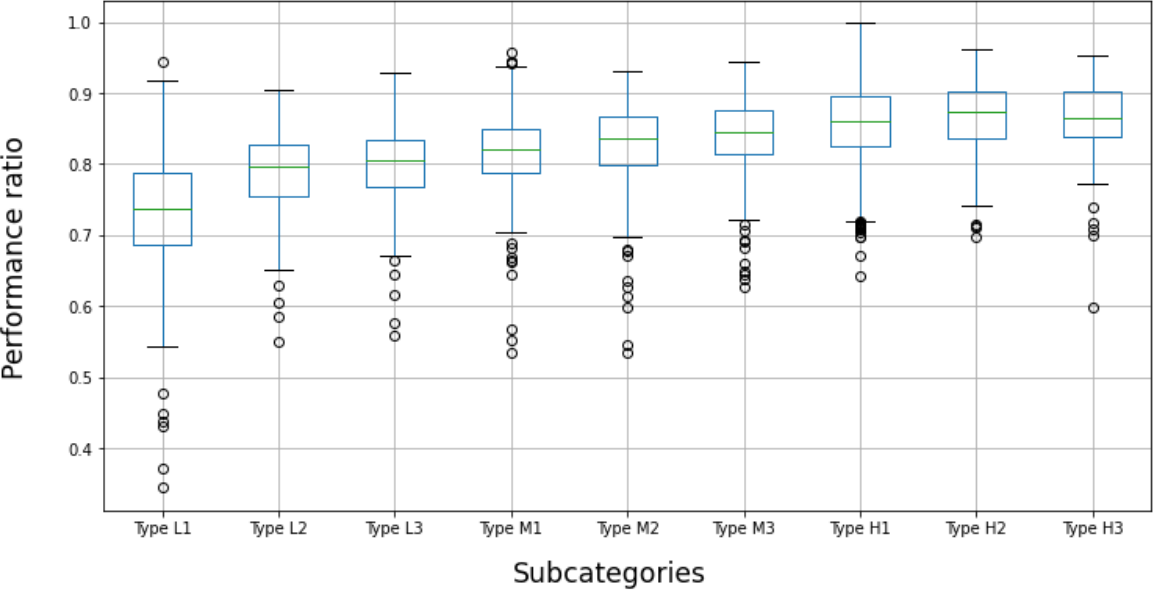
Figure 10. Average daily performance ratio ( PR ) of the set of 26 PV modules together with the inverter in the clusters L1, L2, L3, M1, M2, M3, H1, H2 and H3.